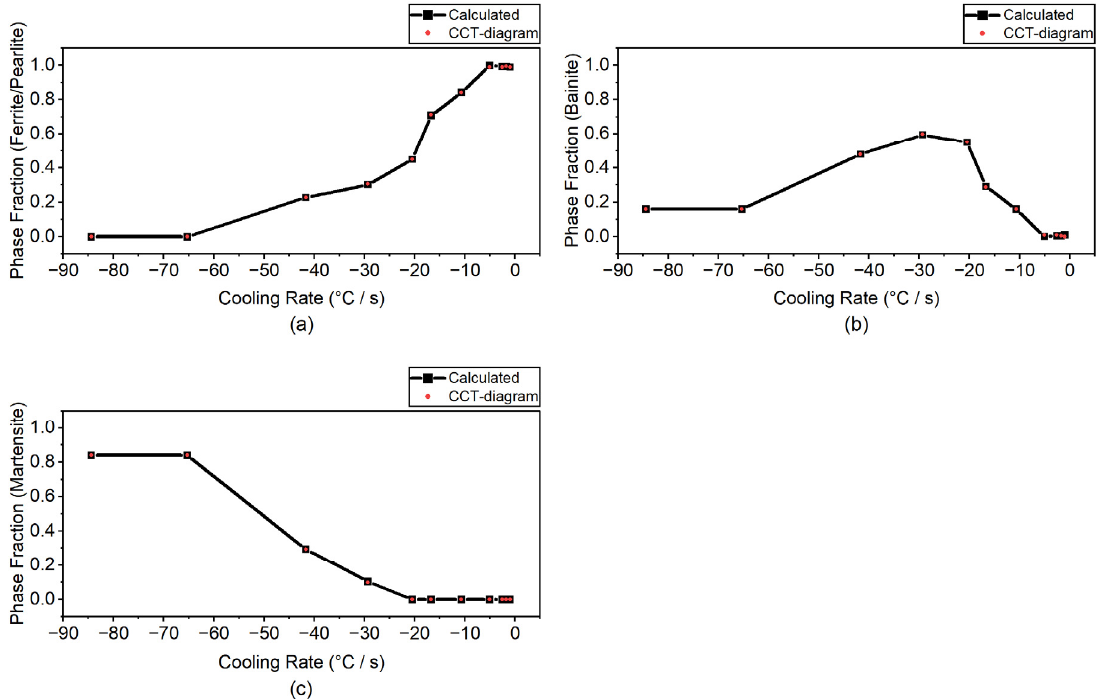
Figure 3. Comparison of the phase fraction calculations using the calibrated parameters in the present study with the ones in the CCT-diagram for ( a ) ferrite/pearlite ( b ) bainite, and ( c ) martensite.